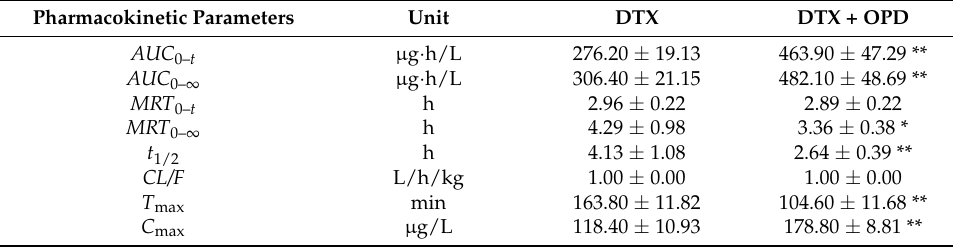
Table 3. Change of pharmacokinetic parameters of DTX in rats with or without OPD ( x ± s , n = 5).